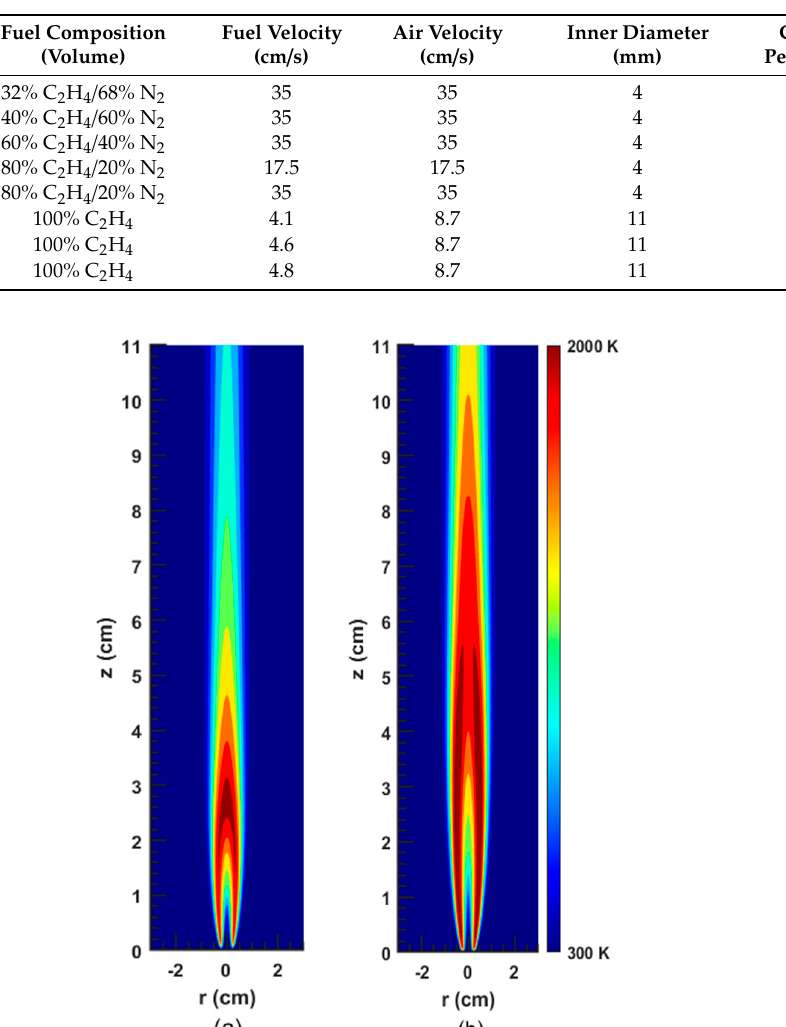
Table 1. The main characteristics of eight laminar flames (Experimental works of a Smooke et al. [43], and b Shaddix and Smyth [44] referred to as “SMXX” and “SYXX”, respectively).